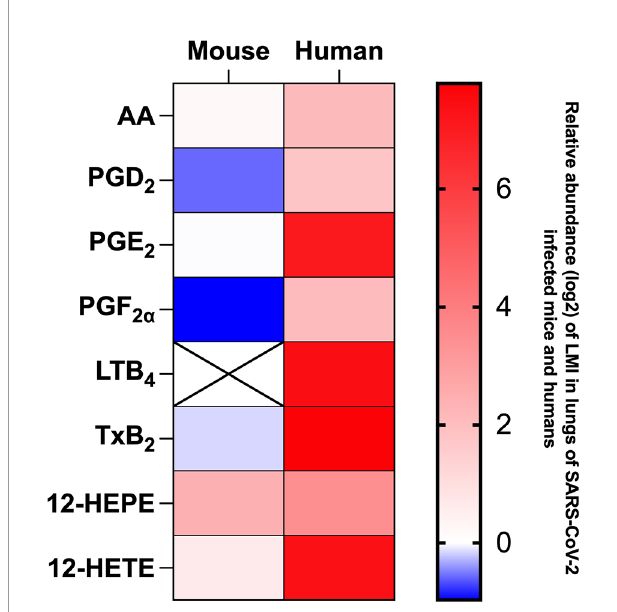
FIGURE 9 | Heat map representation of LMI detected in mouse lung homogenates on day 7 of infection and in bronchoalveolar lavages of hospitalized human patients during severe COVID-19. Results are expressed as log 2 concentration (pg/mL) relative to LMI detected in lung homogenates of mock-infected mice of healthy human